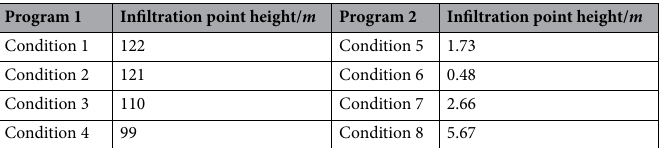
Table 6. Infiltration point height of dam phreatic line under different conditions.